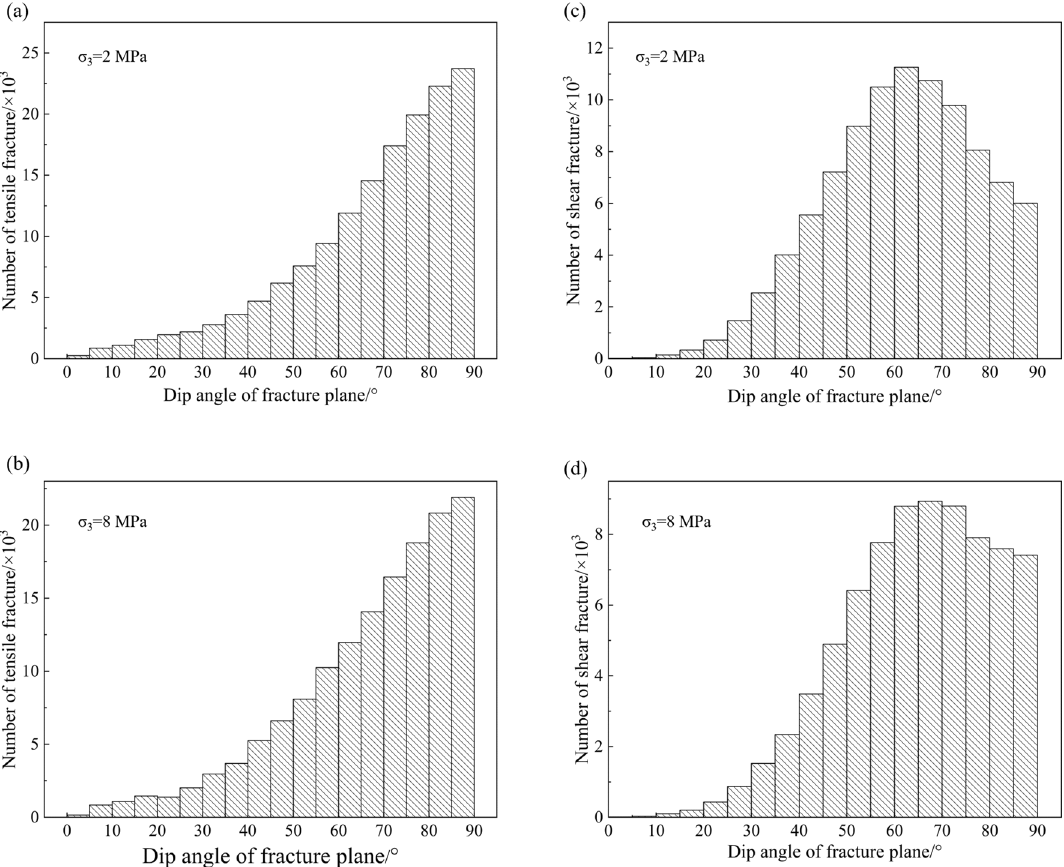
Figure 10. Number of fractures versus dip angle under different confining pressures: ( a , b ) tensile fractures; ( c , d ) shear